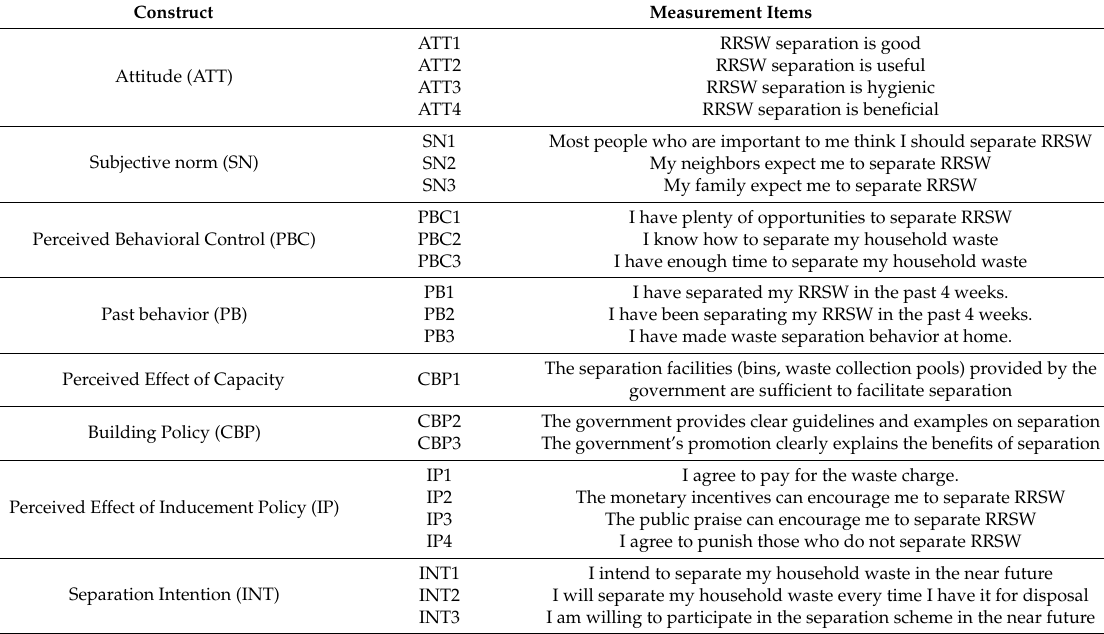
Table 2. Constructs and measurement